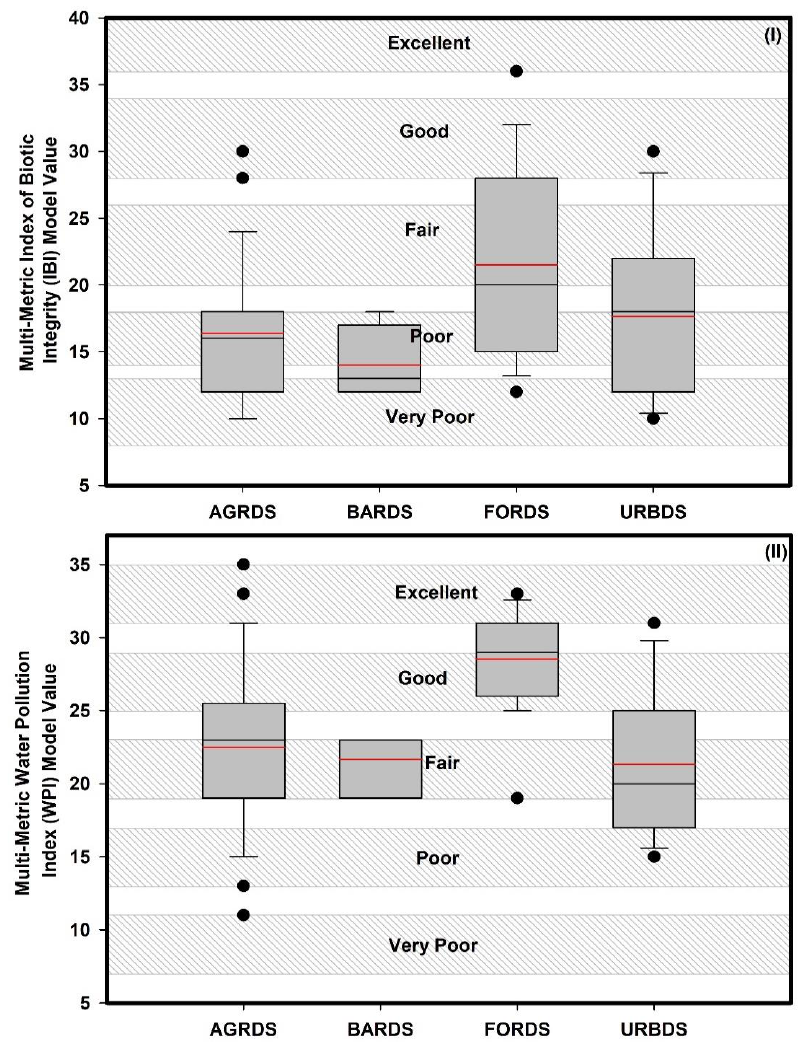
Figure 7. Biological and chemical health assessments at different land cover-dominated sites in the Nakdong River basin. ( I ) index of biotic integrity (IBI) model and ( II ): multi-metric water pollution index (WPI). AGRDS: agricultural coverage-dominated sites, BARDS: barren coverage-dominated sites, FORDS: forest coverage-dominated sites, URBDS: urban coverage-dominated sites (red lines in the box indicate mean value). Table 4. Pearson correlation coefficients ( r ) among nutrients, organic matter, algal chlorophyll with trophic and tolerance guilds, and index of biotic integrity (IBI) model value in the Nakdong River basin. ( − ) indicate a negative relationship. TN: total nitrogen, TP: total phosphorus, BOD: biological oxygen demand, COD: chemical oxygen demand, CHL-a: